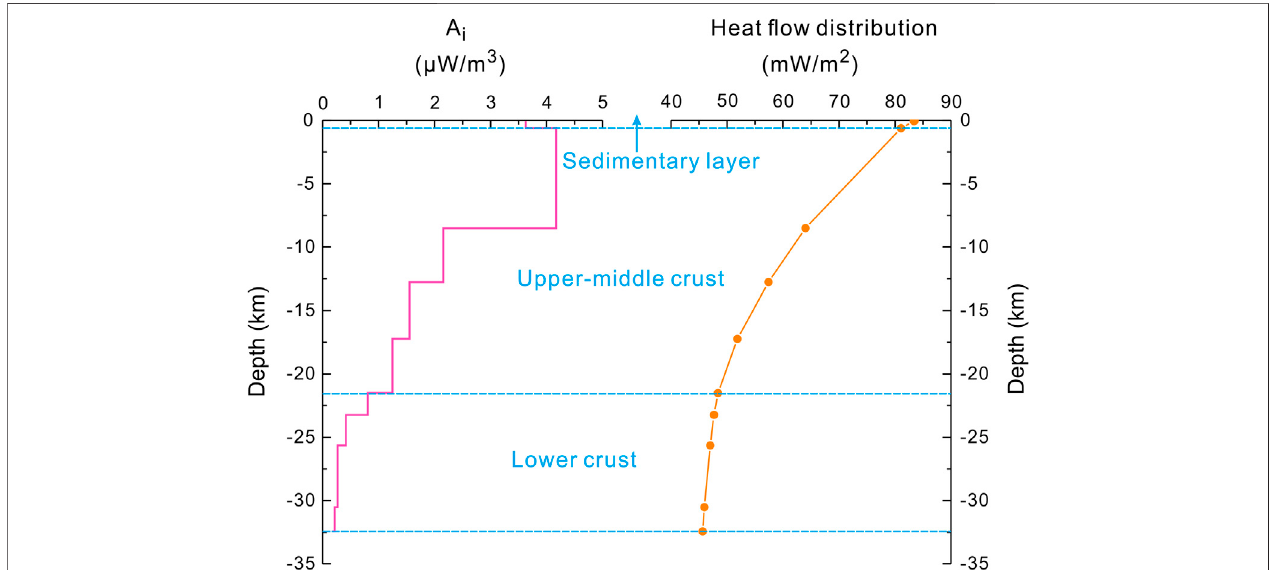
FIGURE 5 | Conceptual model constructed for the lithospheric thermal structure in the study area.